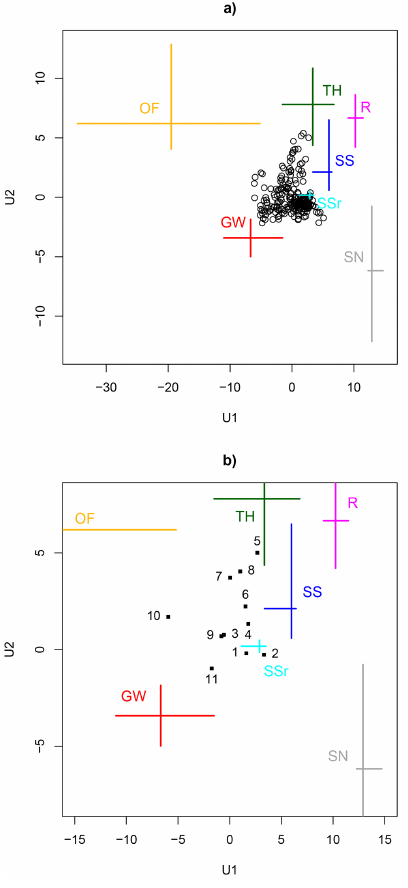
Figure 7. (a) U1–U2 mixing diagram of stream water tracers (black circles; AS + SW in Fig. 5) and (b) zoom into the U1–U2 mix- ing diagram showing event peakflow stream water samples (black squares; numbers identify storm events in Fig. 2). Sampling points data plotted in Fig. 5 were grouped into seven end-members and the interquartile ranges of each end-member were projected into the new mixing space (U space; GW: groundwater; SN: snow; SS: soil water; SSr: soil water from the riparian zone; OF: overland flow; R: rainfall; TH: throughfall). Because (b) is a zoom into the U1–U2 mixing diagram, the interquartile ranges of some end-members are not fully represented.